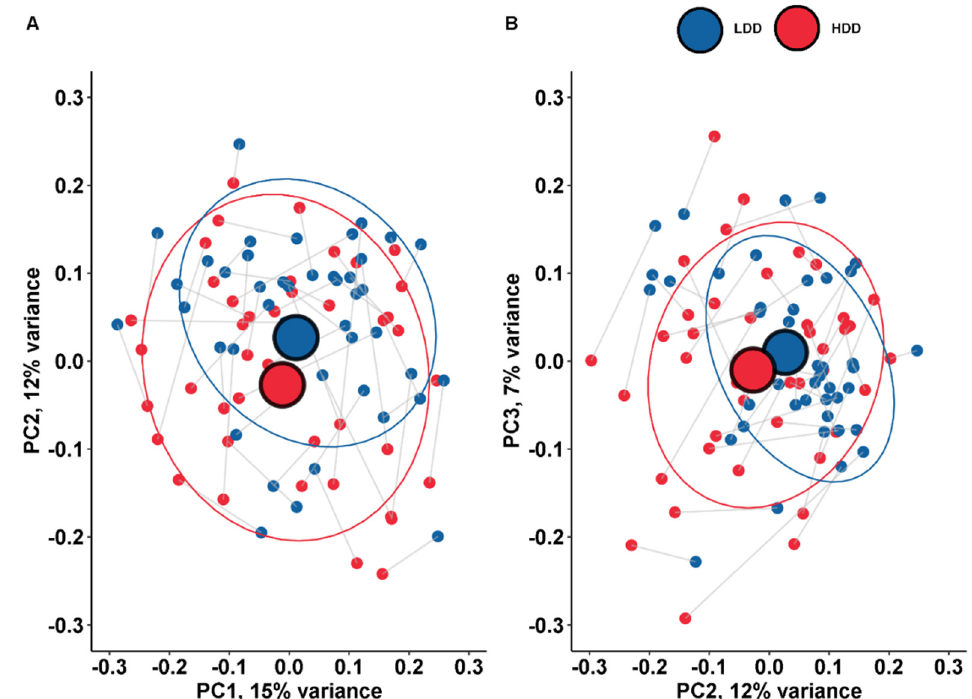
Figure 1. Principle coordinate analysis on the species level. The lines represent the intra-individual link of participants. This graph represents the difference between the low-dairy diet (LDD) and the high-dairy-diet (HDD) on the species level ( n = 46). ( A ) PC1 and PC2 were not significantly different during the HDD and the LDD ( p = 0.49 and p = 0.06). PC1 explained 15% of the total variance and PC2 explained 12% of variance. ( B ) PC2 and PC3 were not significantly different during the HDD and the LDD ( p = 0.06 and p = 0.40). PC3 explained 7% of variance.